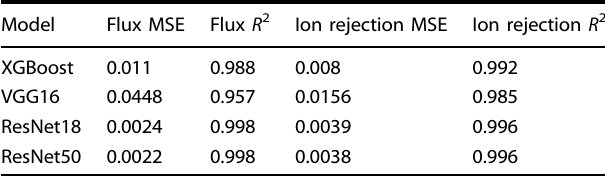
Values based on standardized water fl ux/ion